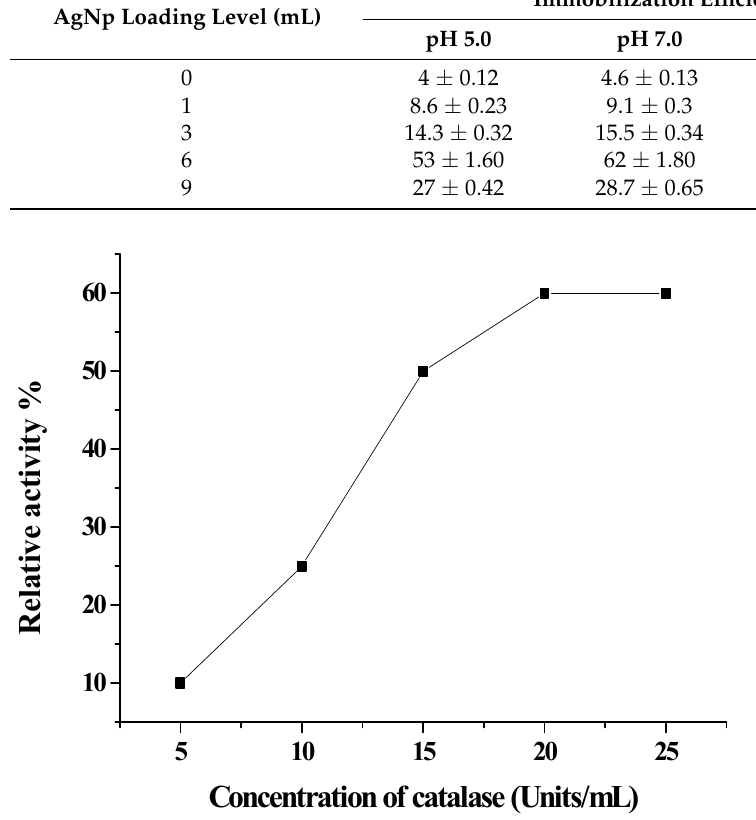
Figure 1. The influence of enzyme concentration on the rate of immobilized catalase. The morphology of the CF, AgNp-CF and AgNP-CF-catalase samples are shown in Figure 2. As evidence of the loading success of AgNp onto cotton fabric and its enzyme immobilized form, the morphological changes were assessed using SEM. Figure 2 shows the morphological changes for samples A (blank), B (6 mL sample AgNp coated fabric), and C (catalase immobilized onto 6 mL sample AgNp coated fabric). It is clearly observed that sample A appeared as a smooth surface and became dotted with AgNp after being coated with a 6 mL loading level. Upon enzyme immobilization, the dots became covered with the enzyme that appeared as small aggregates. The advantage of enzyme immobilization in terms of its reusability was assessed. The support was thoroughly washed with water after each reuse. In Figure 3, over ten reuses and the results indicated a 67% retention of its initial activity. Similar results of reusability of immobilized catalases were determine [37,38]. The reduction of the activity after each reuse is due to the assay conditions [39,40]. ( A )